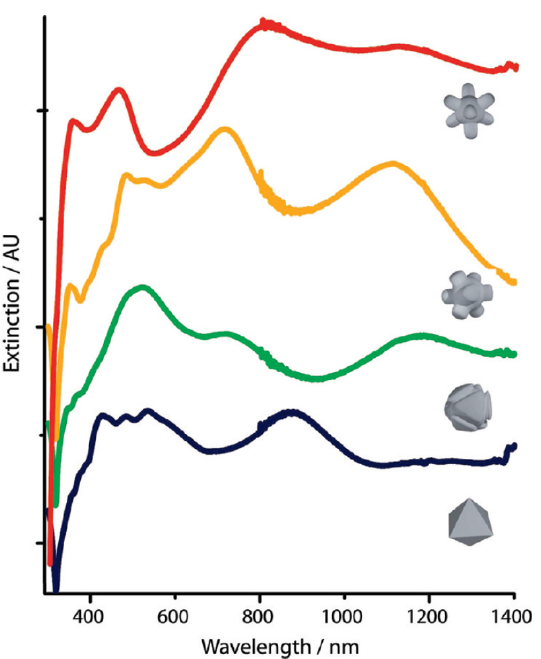
Figure 6. UV-vis-NIR spectra of AgNPs during an etching process starting from octahedral-shaped particles. Etchant solution: H 2 O 2 /NH 4 OH/CrO 3 in a 1:5:0.08 ratio. Reprinted with permission from [95], copyright 2010, American Chemical Society.